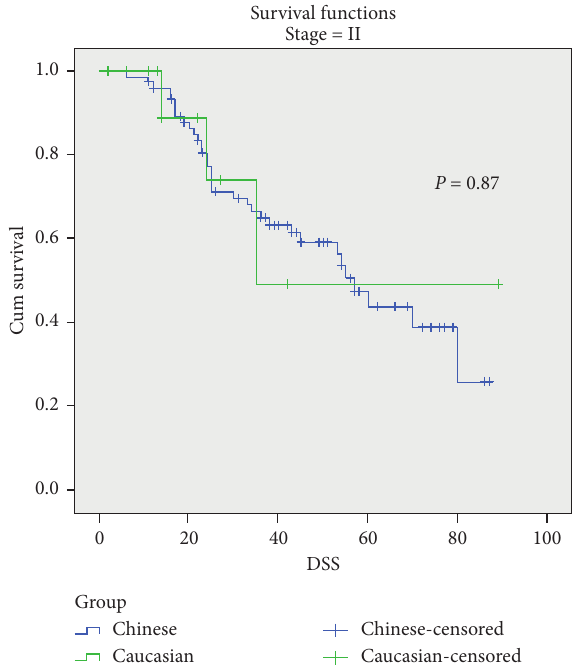
Figure 3: Stage-stratified 5-yr DSS in Chinese and Caucasian groups. Stage III, p � 0 .